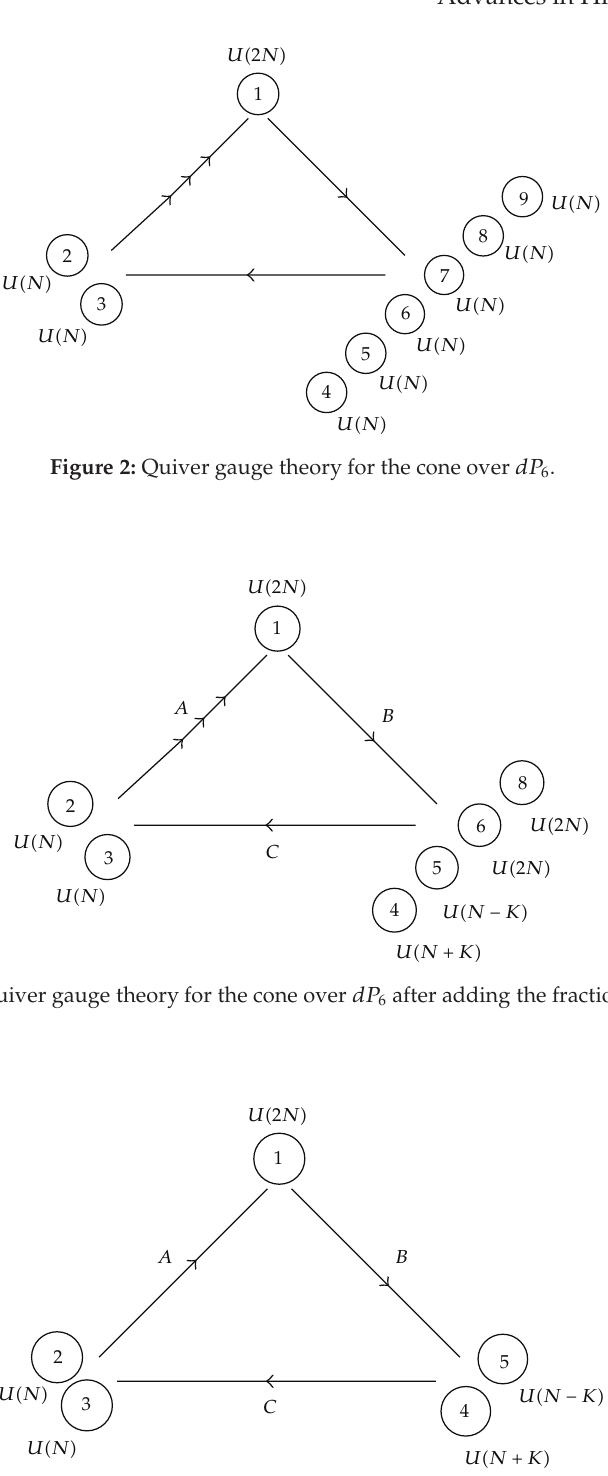
Figure 4: Quiver gauge theory for the cone over dP 6 after confinement of nodes 6 and